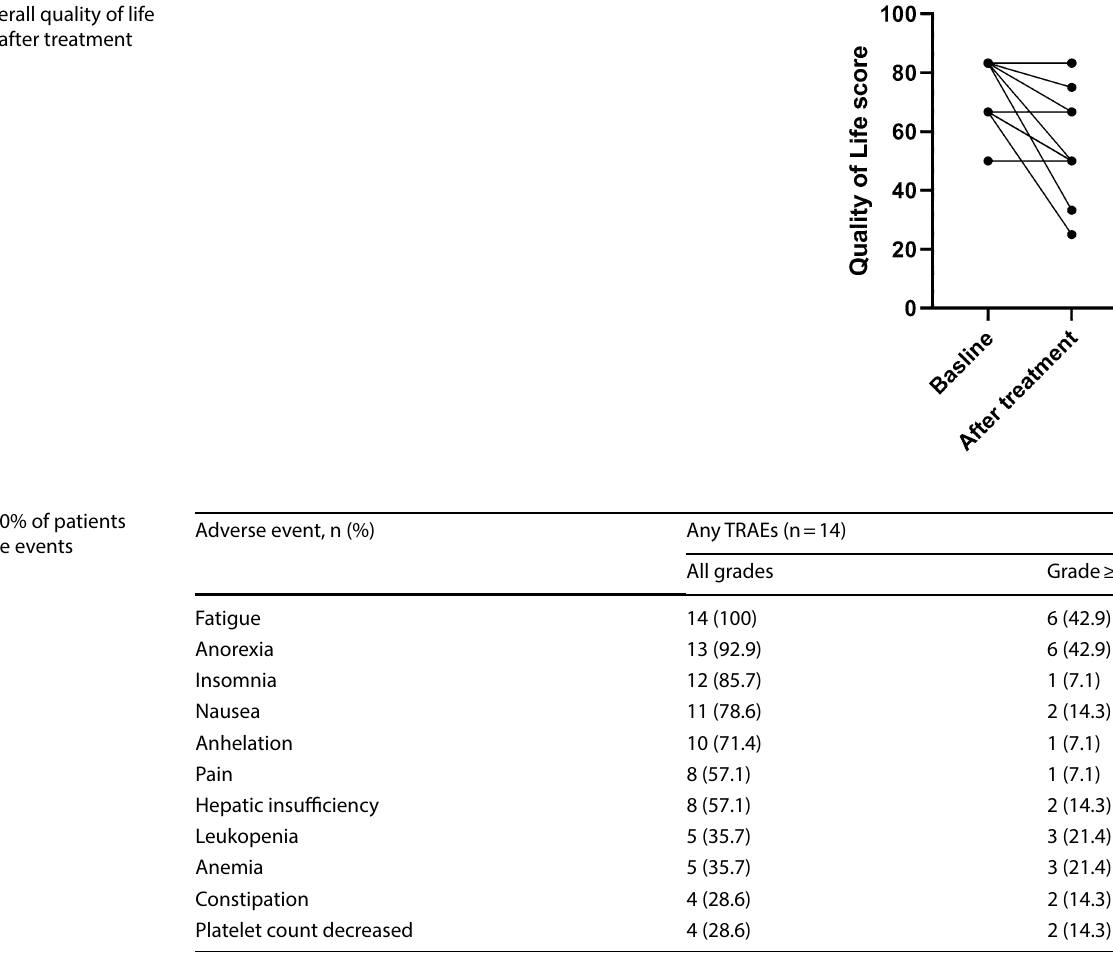
Fig. 4 The standard score of patients’ overall quality of life before and after treatment